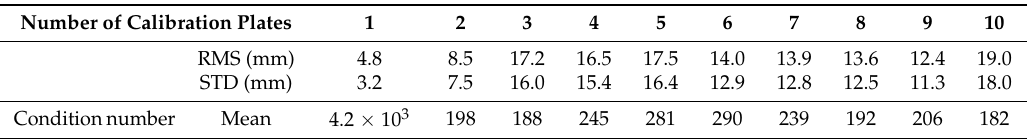
Table 1. RMS error metric and standard deviation of a single calibration (100 points) with a different number of calibration plates. Also, the mean condition number (closer to 1 is better) of the Hessian of the cost function is given.